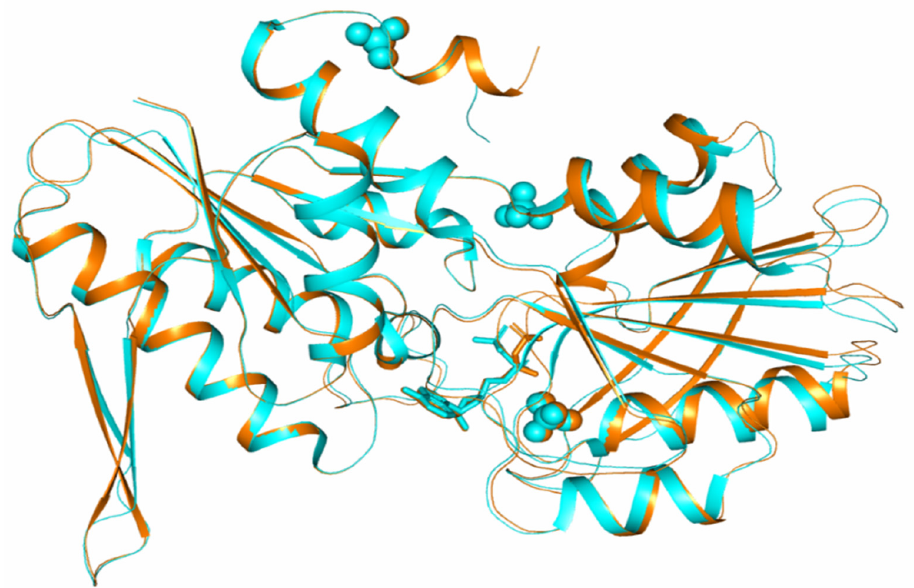
Figure 3. Comparison of the conformations of subunits of TthPRPPS2 in two crystal modifications. Subunits superimposed by 255 C α atoms.